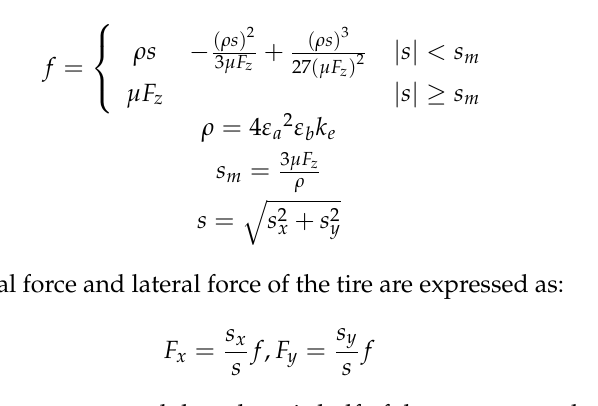
Figure 2. Lateral force calculation of brush tire model and MF tire model. The joint longitudinal force and lateral force model is defined